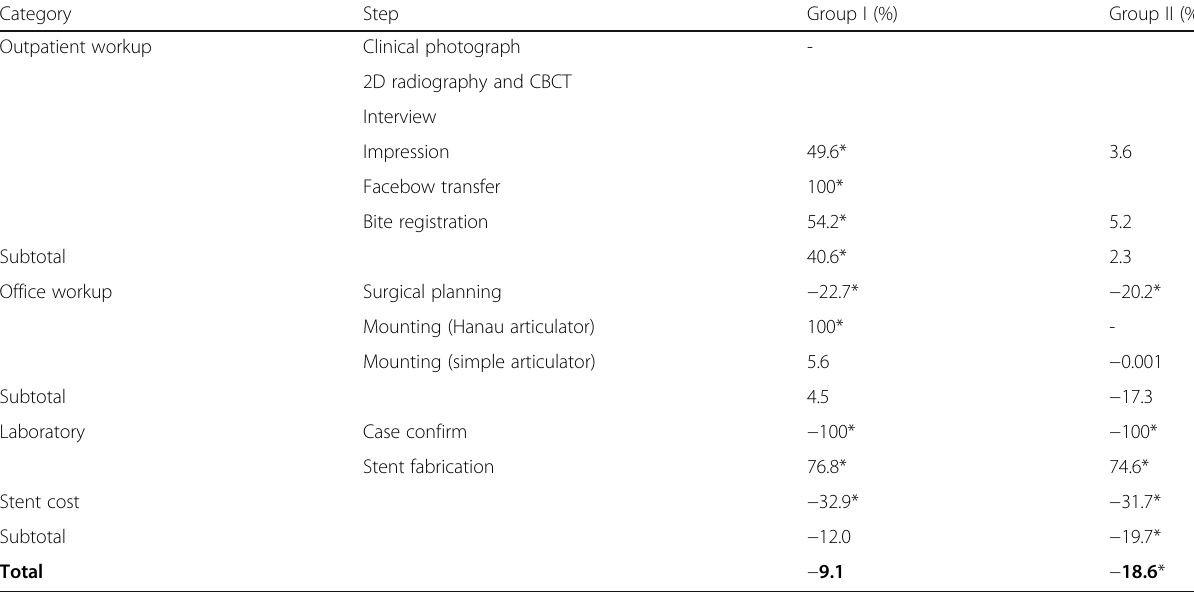
Table 5 Cost reduction rate for each category in VSP comparing with CSP